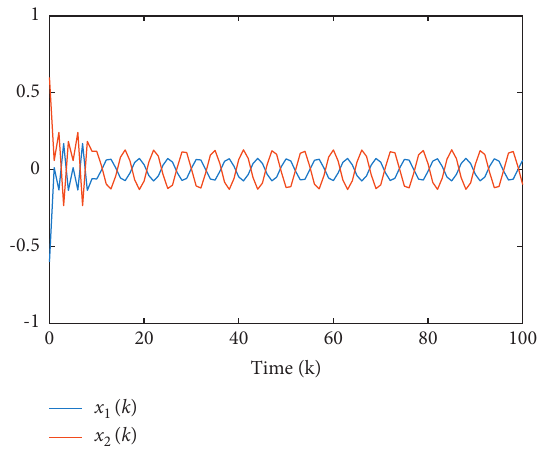
Figure 2: State trajectories x ( k ) of the system with PID control.